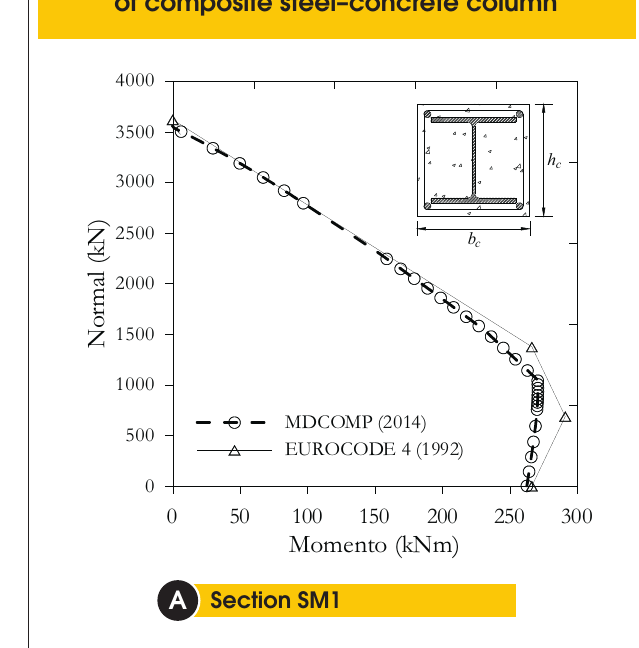
Figure 6 – Interaction curve of cross–sections of composite steel–concrete